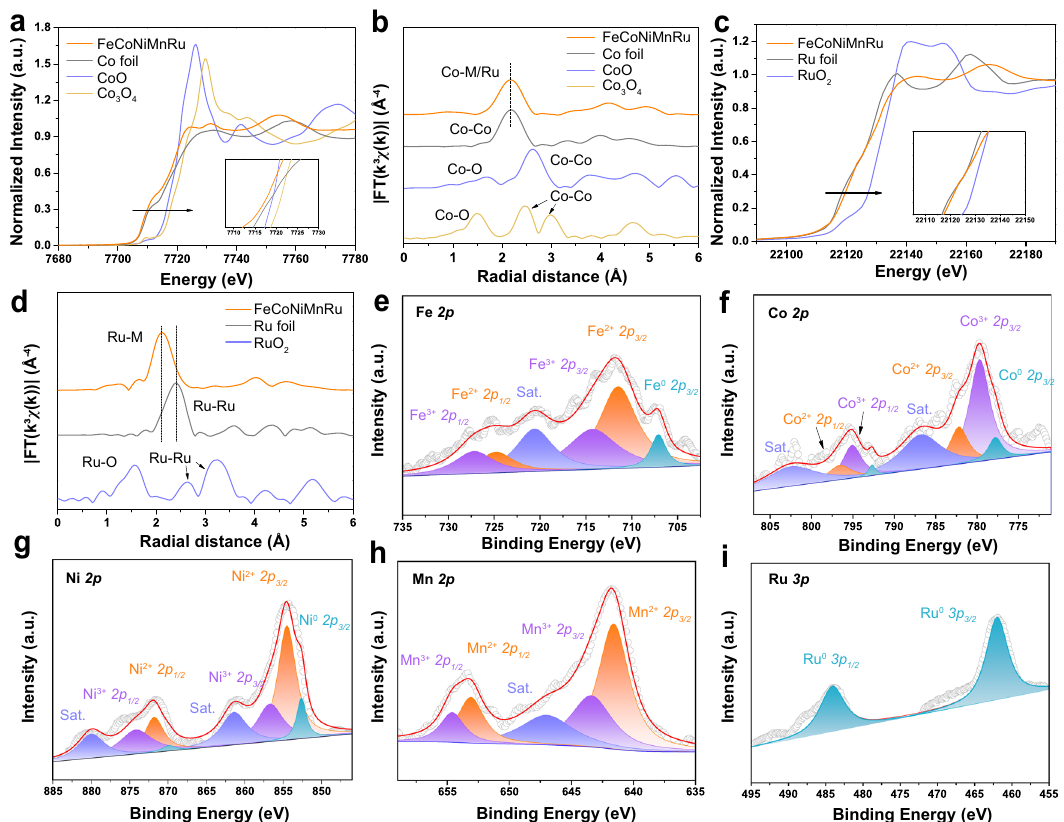
Fig. 3 Surface chemical states characterized by X-ray absorption spectroscopy (XAS) and X-ray photoelectron spectroscopy (XPS). a The Co K-edge XANES spectra and b FT-EXAFS spectra of FeCoNiMnRu/CNFs, Co foil, CoO foil, and Co 3 O 4 foil. c The Ru K-edge XANES spectra and d FT-EXAFS spectra of FeCoNiMnRu/CNFs, Ru foil, and RuO 2 foil. High-resolution XPS spectra of as-prepared FeCoNiMnRu/CNFs: e Fe 2 p , f Co 2 p , g Ni 2 p , h Mn 2 p , and i Ru 3 p